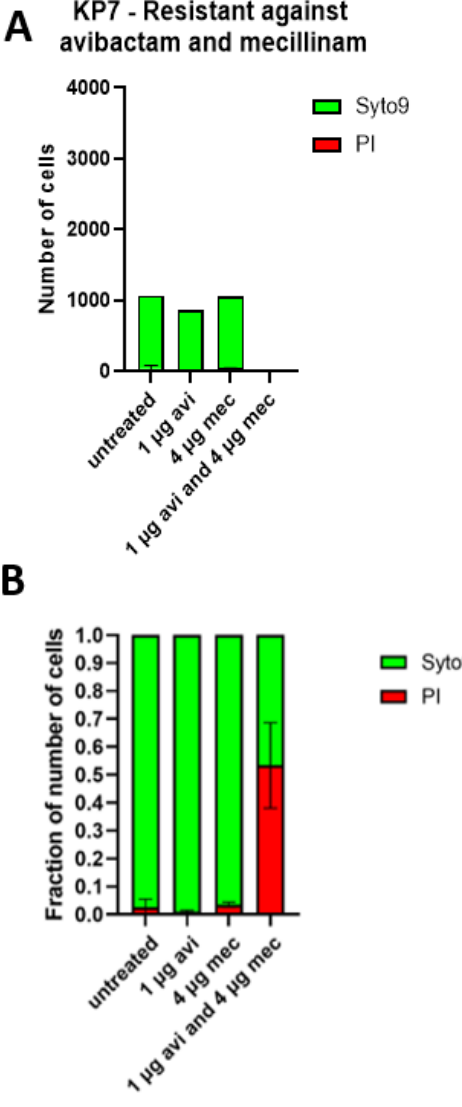
Figure 4. Confocal laser scanning microscopy. Quantified data showed the average number of cells found in confocal laser scanning micrographs of cultures treated either with 4 µ g mL − 1